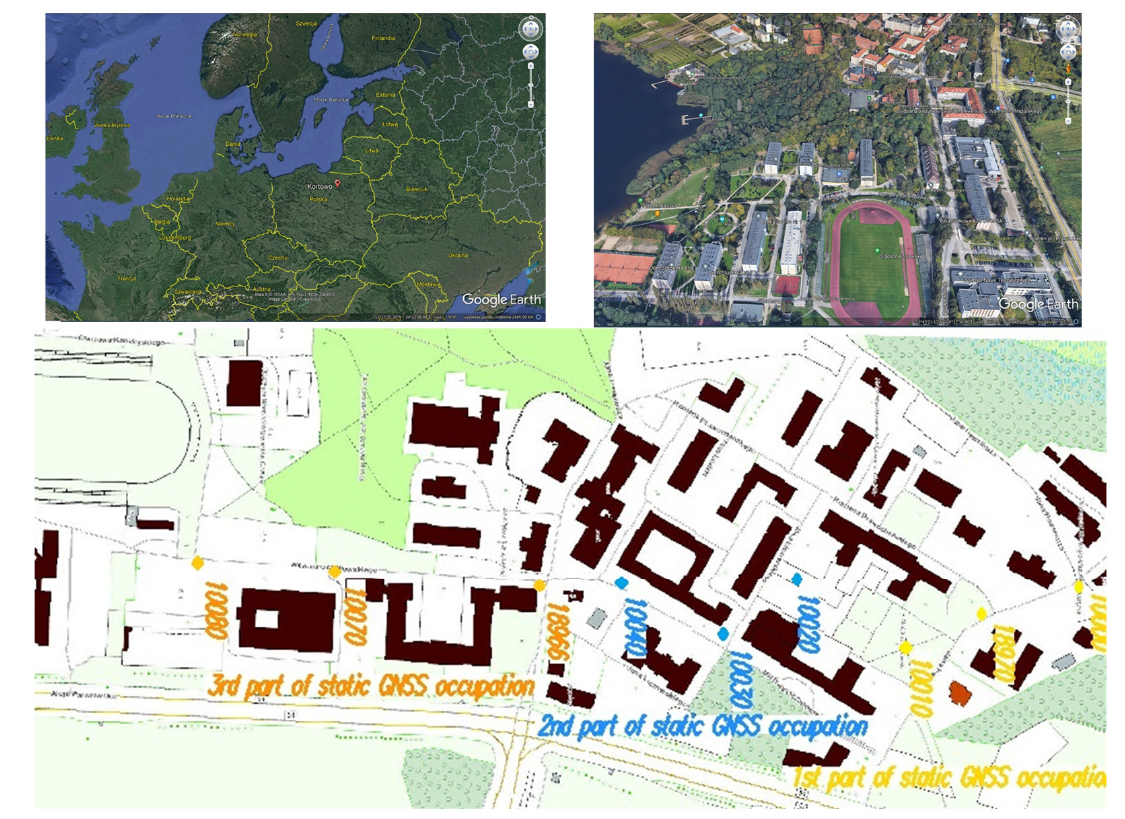
Figure 1. Localization of analyzed control network points on the Kortowo campus.